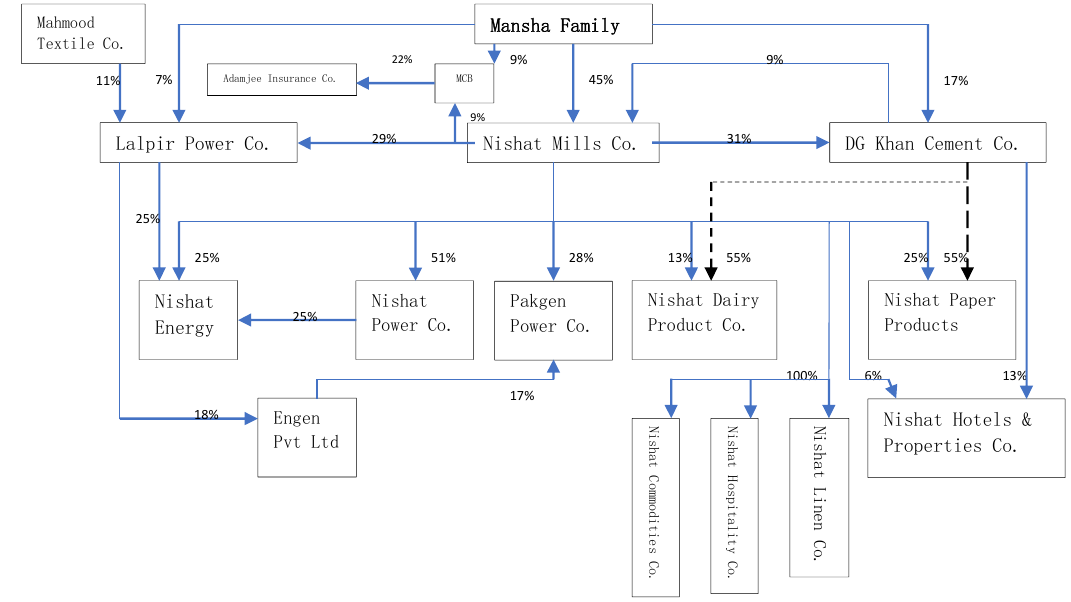
Figure 1. The example of complex ownership and control chain structure of a family in